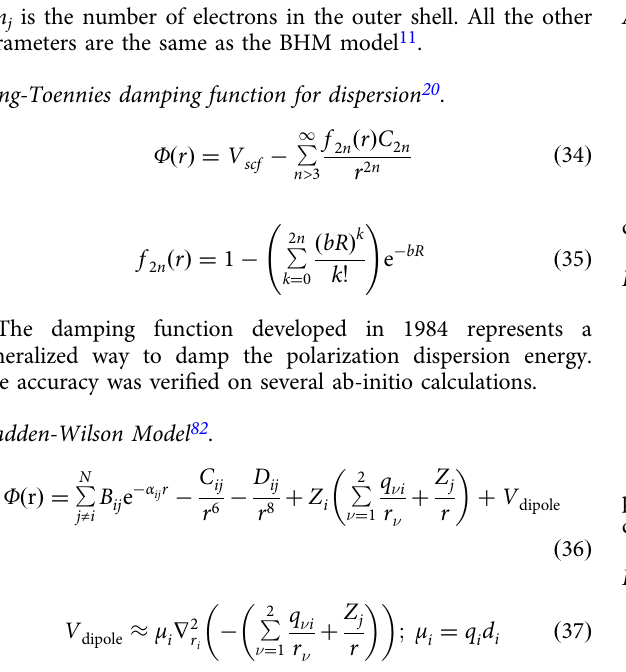
Aspherical Ion Model 25,28 .